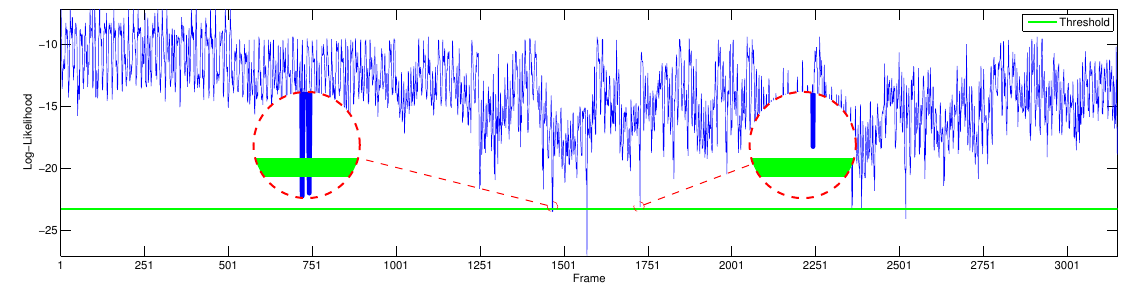
Figure 2. Threshold example: the log-likelihood exceeds the threshold; the abnormal event detected ( left circle ); the log-likelihood does not exceed the threshold, normal event ( right circle ). The y-axis represents the log-likelihood value computed for each frame, while the x-axis represents the frame